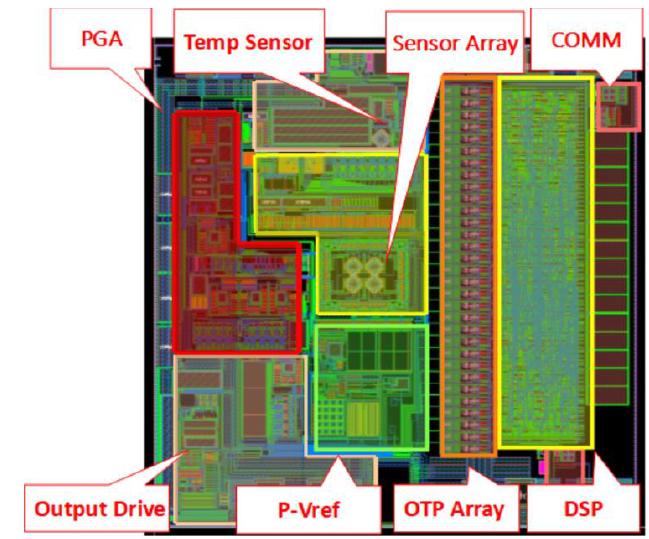
Figure 9. Magnetic flux gate current sensing chip function block diagram.